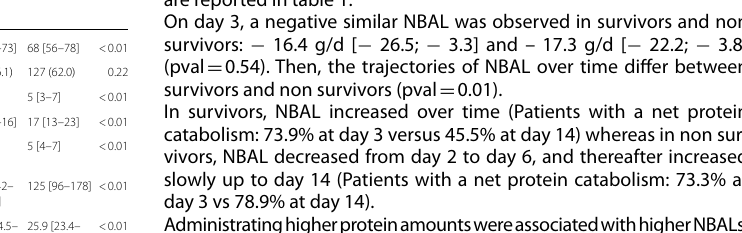
Table 2: Characteristics and outcomes of patients according to nutri- tional risk scores’ thresholds (*median, [IQR]) mNU- mNU- TRIC < 4 TRIC ≥ 4 (n = 231) (n = 166)